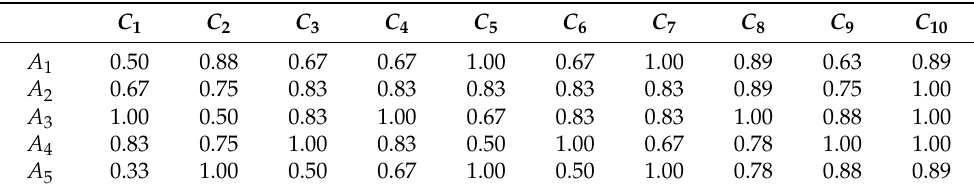
Table 17. The normalized ratings of alternatives.